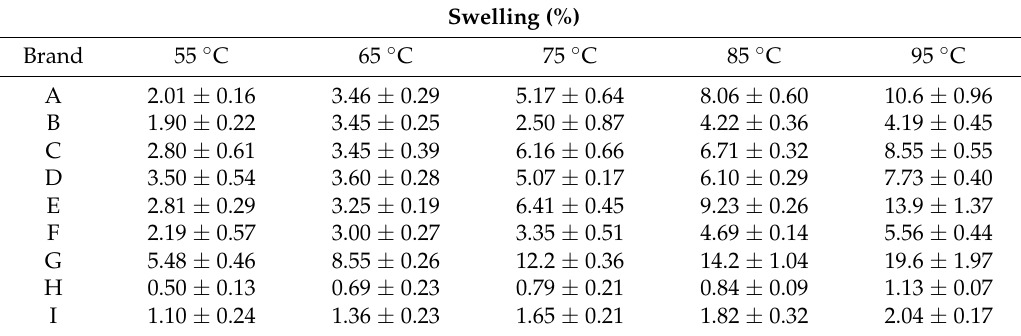
Table 7. Swelling analysis of herbal pharmaceutical products at different